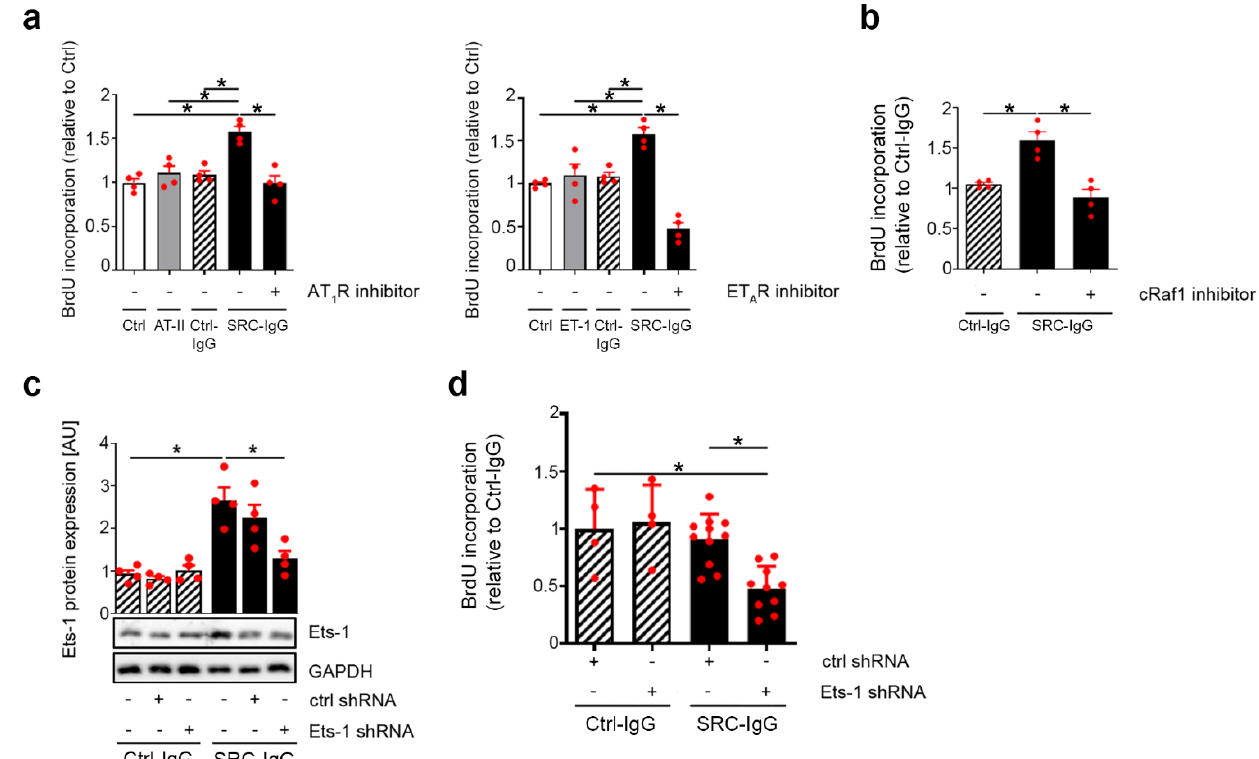
Figure 2. Endothelial cell proliferation elicited by SRC-IgG via ERK1/2–Ets-1 signaling. Non-stimulated cells (Ctrl) were used as reference when natural ligands were included, whereas Ctrl-IgG served as reference when only IgG were used. HMEC-1 were stimulated for 24 h with either natural ligands, Ctrl- or SRC-IgG, and specificity was assessed via two-hour pre-incubation with corresponding receptor inhibitors ( a ) ( left and right ) or cRaf1 inhibitor ( b ). ( c ) Abolition of Ets-1 translational regulation by shRNA following six-hour HMEC-1 stimulation. Ctrl shRNA corresponds to a mix of three control shRNA plasmids. Blots were over-exposed to better appreciate the decrease in the protein level. ( d ) Decrease in SRC-IgG induced endothelial cell proliferation by Ets-1 knockdown. ( a – c ) n = 4, ( d ) 7 ≤ n ≤ 11; representative blots are shown. * p < 0.05.